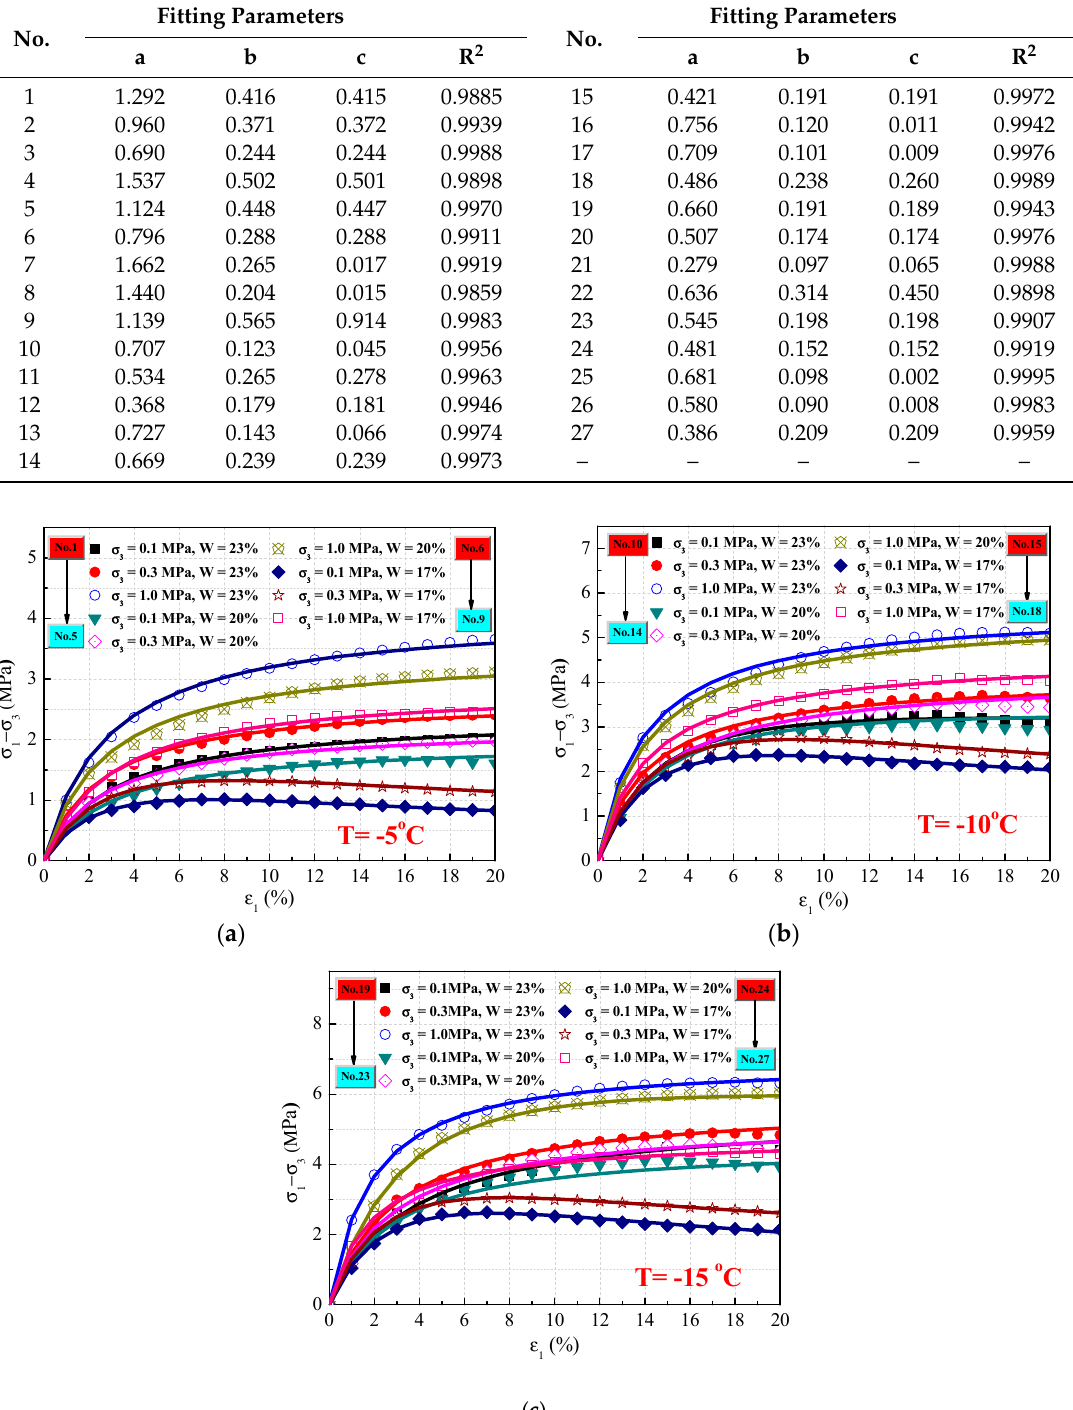
Figure 7. Comparison of the experimental (symbols) and predicted (lines) stress–strain curves of the MDC model. ( a ) T = − 5 ◦ C; ( b ) T = − 10 ◦ C; ( c ) T = − 15 ◦ C